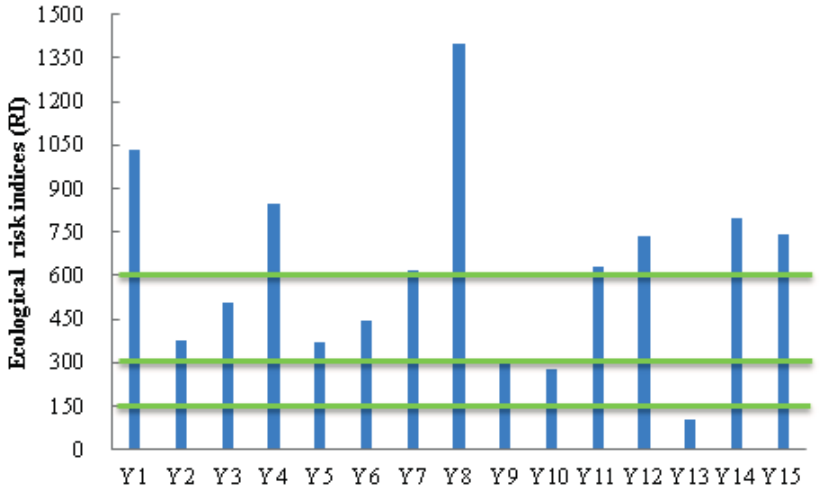
Figure 3. Potential ecological risk indices (RI) of heavy metals in surface sediments from the Yanghe